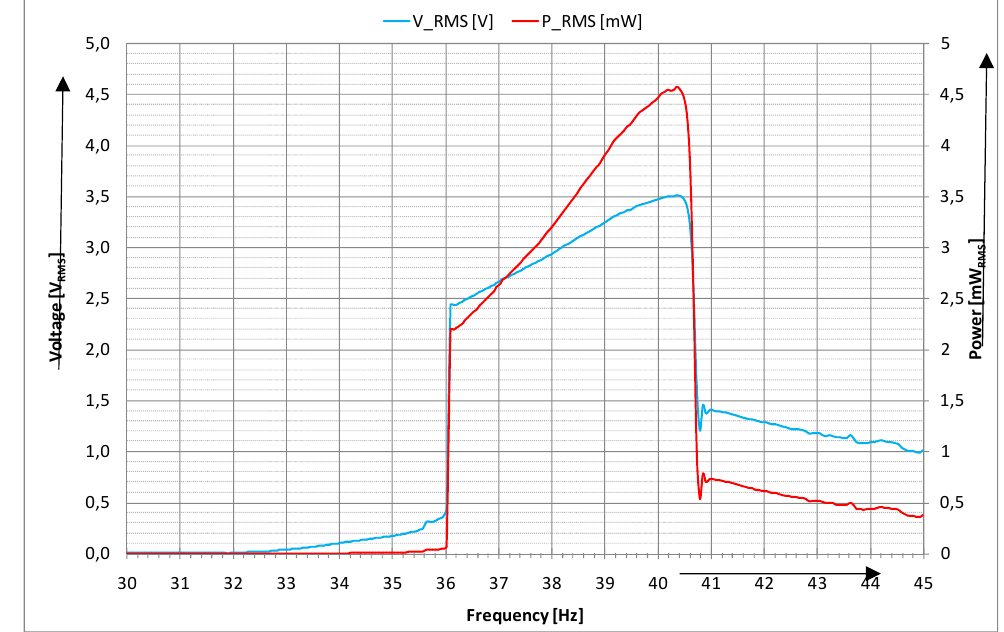
Figure 9. The MG experimental measurement, root mean square (RMS) output voltage V_RMS, power P_RMS vs. frequency , f requency sweep with R L = 2.7kOhm, G = 0.5 g RMS, main operational resonant frequency.